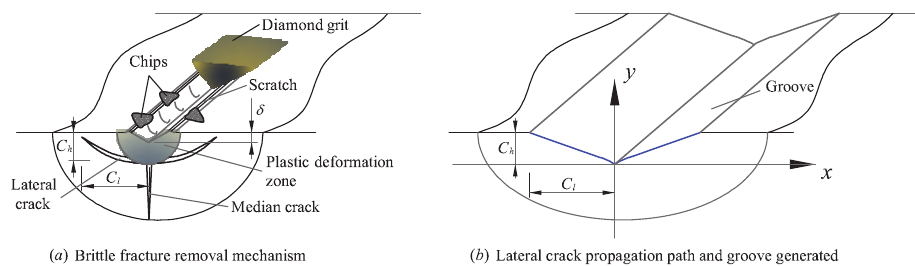
Figure 1. Brittle fracture removal mechanism and the lateral crack propagation path.